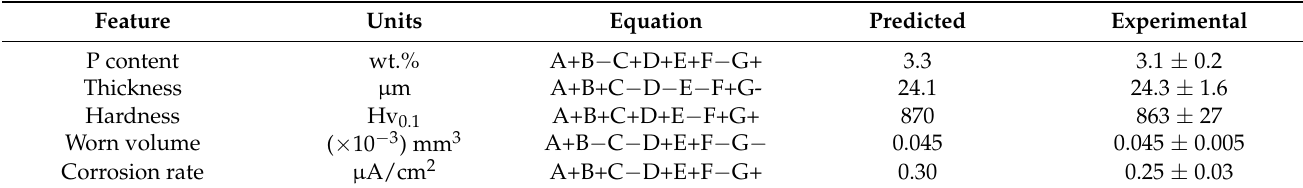
Table 6. Summary of the univariate optimization results for the features or properties considered in this study. Feature